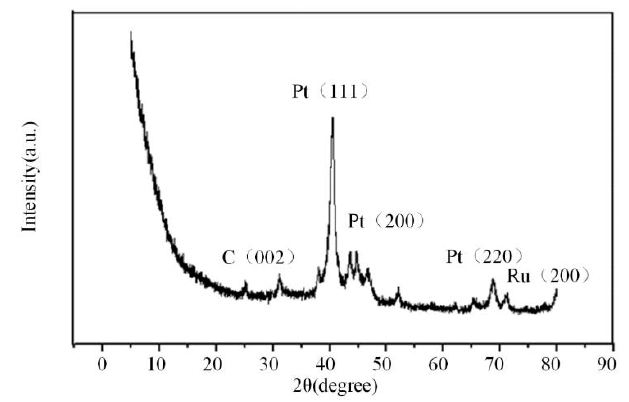
Figure 6. XRD diagram of PtRu/NG catalyst membrane.